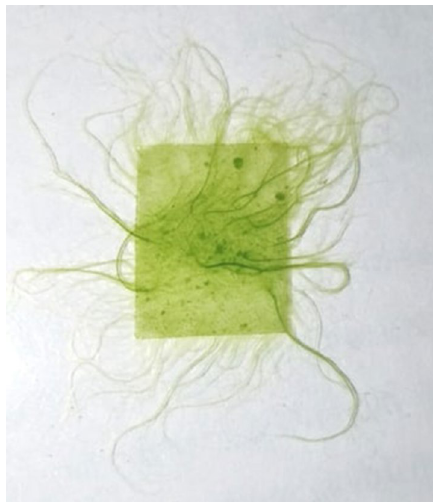
Figure 8. Microalga treated LDPE sheet (1 cm 2 ) showing green hair-like structures protruding from the LDPE